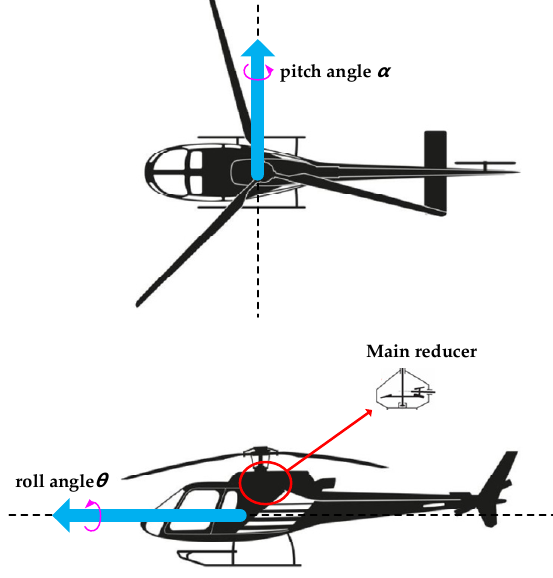
Figure 9. Definition of flight pitch and roll angles.